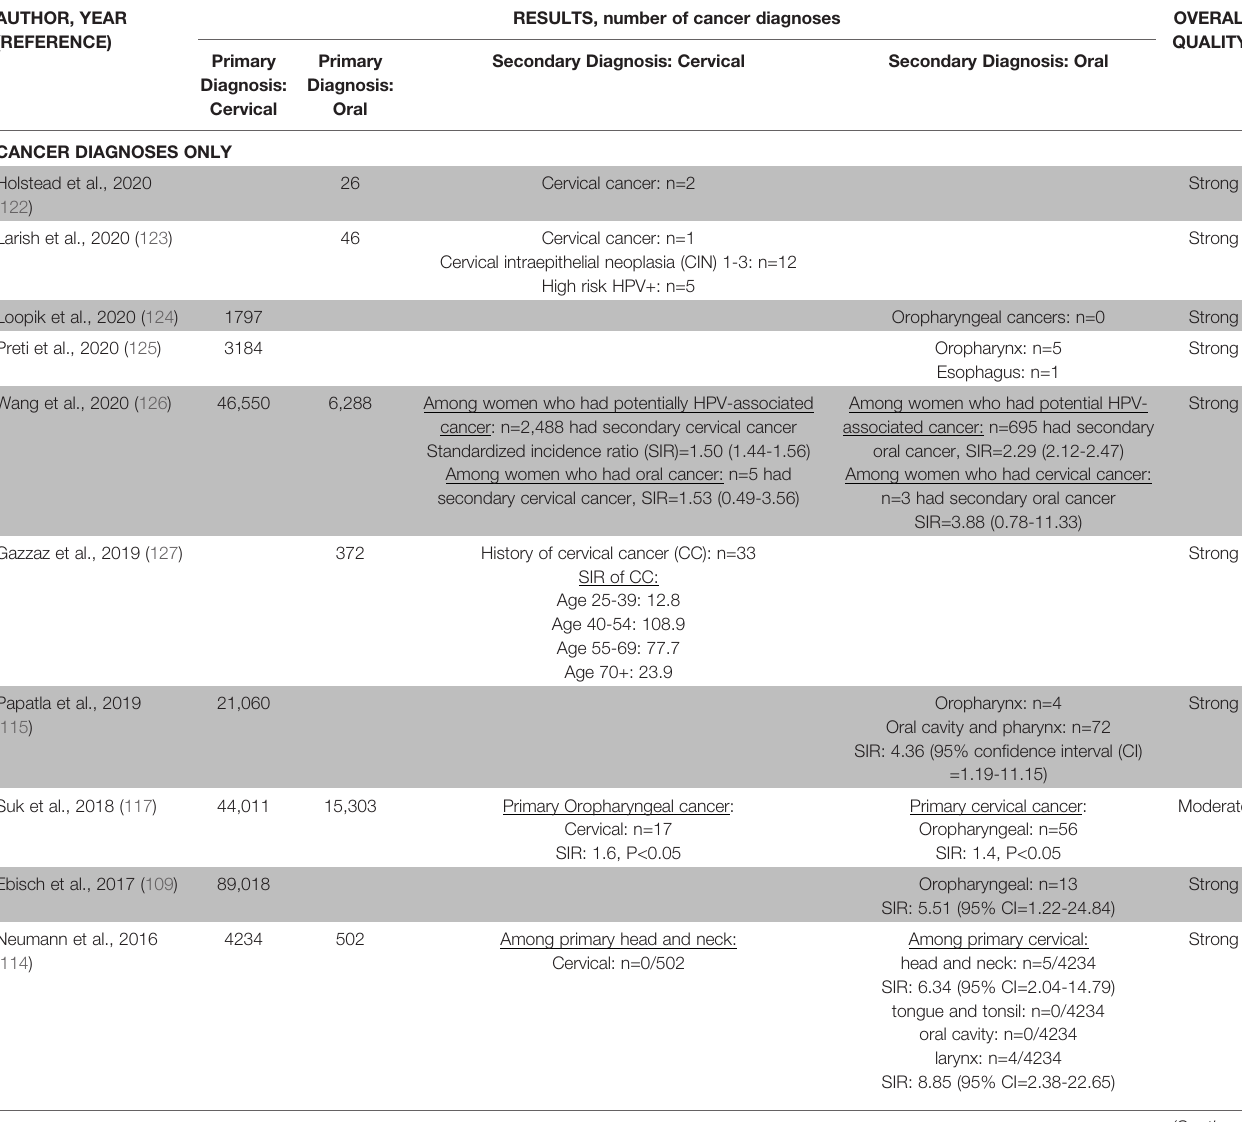
TABLE 3C | Results of the oral-cervical human papillomavirus (HPV)-related cancer diagnoses only papers